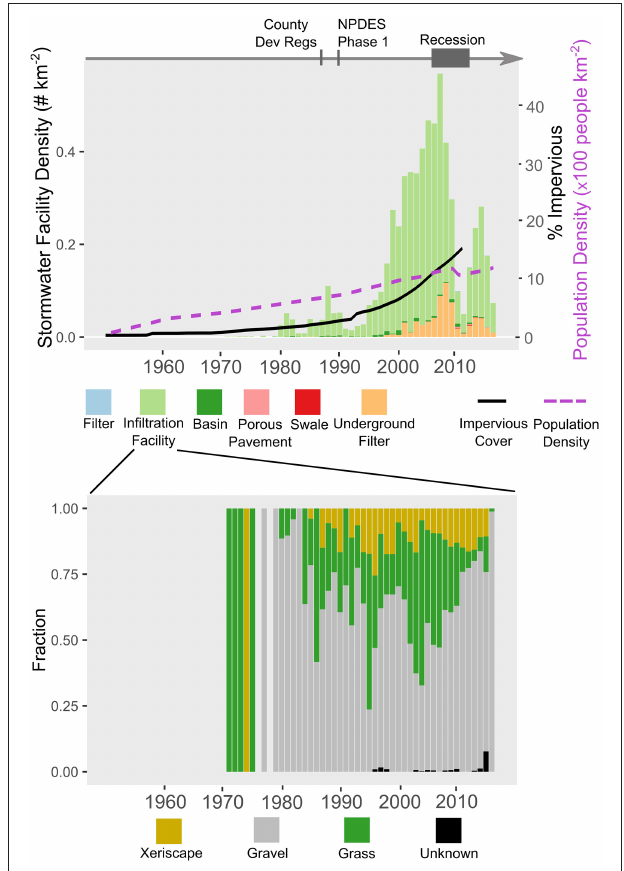
FIGURE 5 | A timeseries of SCM construction in Phoenix, represented as the number of facilities built during a given year, normalized by the current area of the city. The arrow at the top denotes important events influencing stormwater management, the black line graph represents impervious surface change in Phoenix over several decades, and the dotted purple line graph indicates change in population density. An additional panel below depicts the fraction of different ground cover types for infiltration facilities (specifically retention basins). “Unknown” cover indicates facilities where data on the type of ground cover was not available.